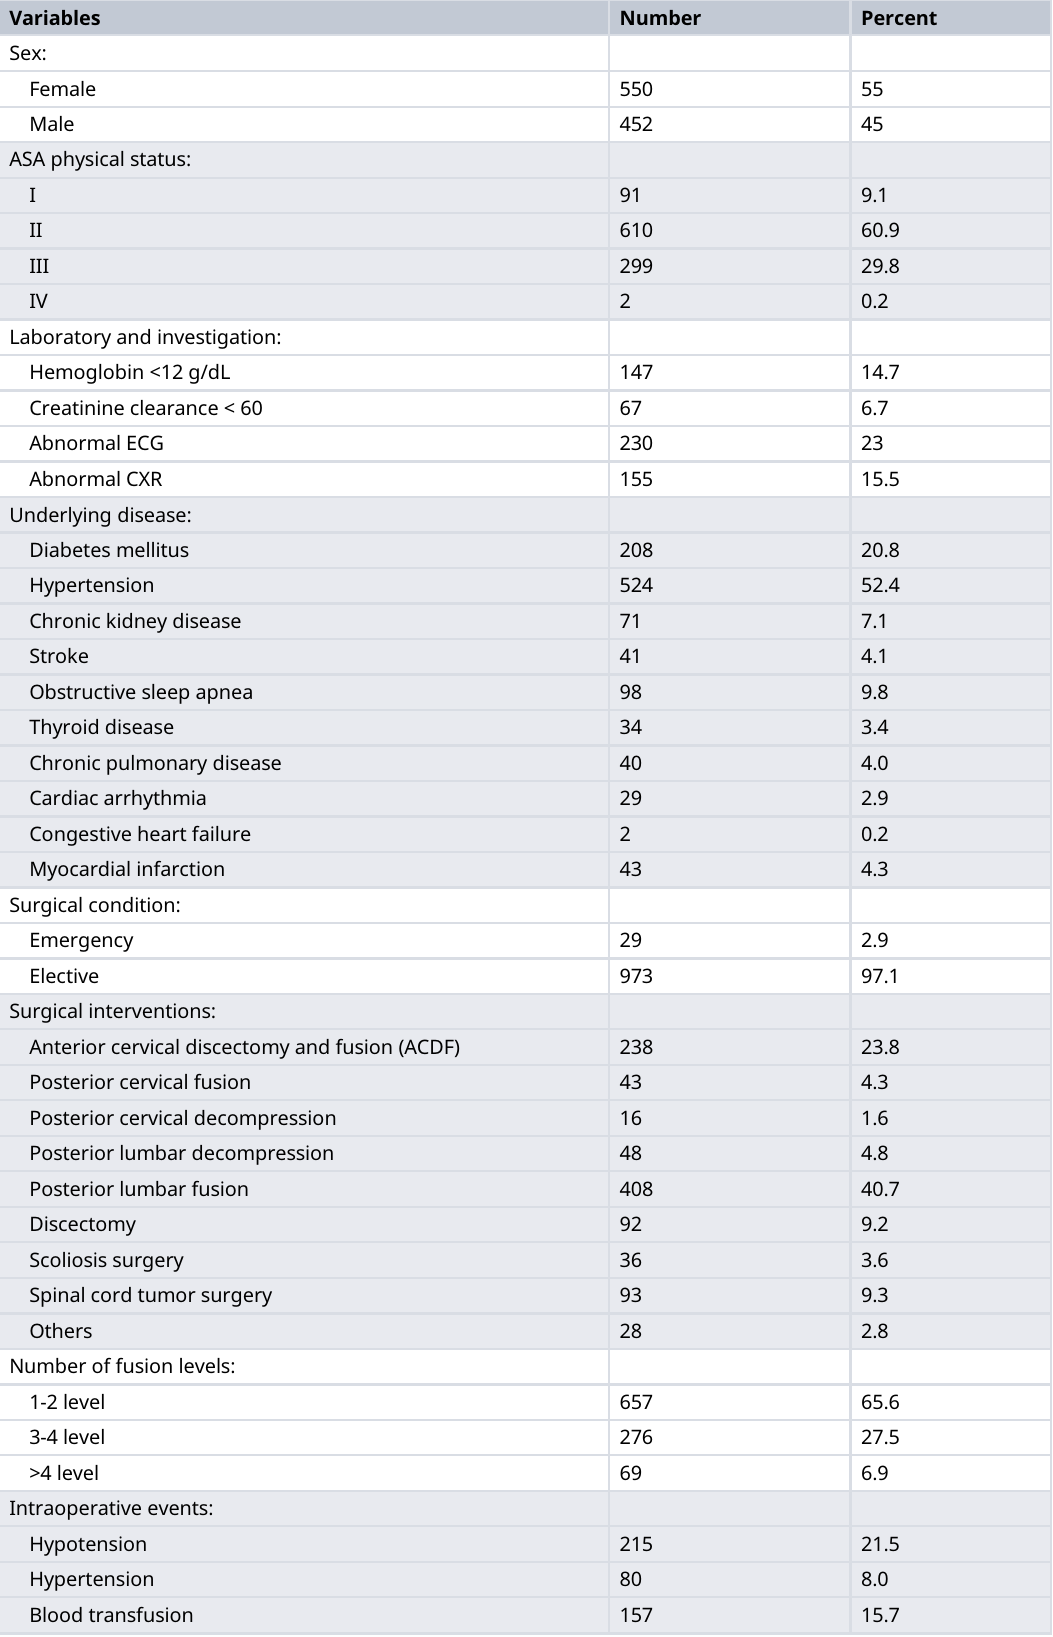
Table 1. Patient demographics, surgical factors, and anesthesia factors. Variables